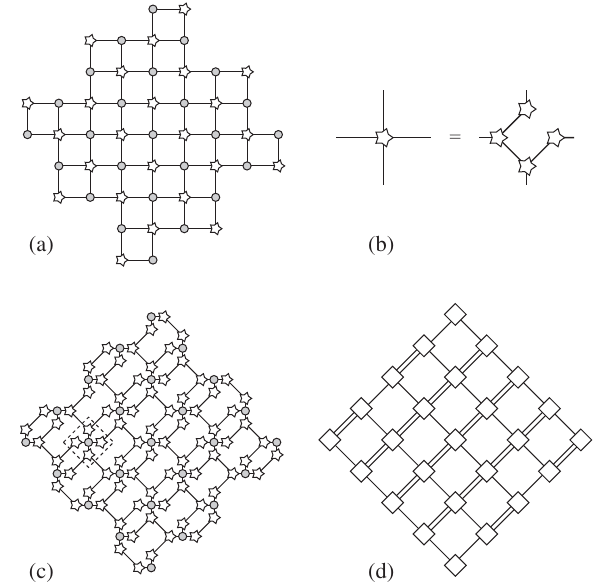
FIG. 14. (a) Tensor network representing a coset probability for a rotated code. It consists of qubit tensors (circles) and check tensors (stars). The layout in (a) is obtained by applying the construction of Ref. [9] to the rotated code without modification. (b) Splitting a check tensor into multiple check tensors. This splitting is possible because check tensors take the value one if all indices are identical and zero otherwise. (c) A modified tensor network representing a coset probability where a single cell is outlined by a dashed box. This network is obtained from (a) by splitting check tensors. (d) Final modified tensor network obtained by contracting tensors in cells together to form merged tensors (squares). In the discussion of the contraction of this tensor network, we imagine rotating the network anticlockwise by 45° and contracting from left to right. Note that this tensor network is not isotropic: In this rotated frame, the bond dimension is 2 for horizontal edges and is 4 for most vertical edges (except on the boundary).